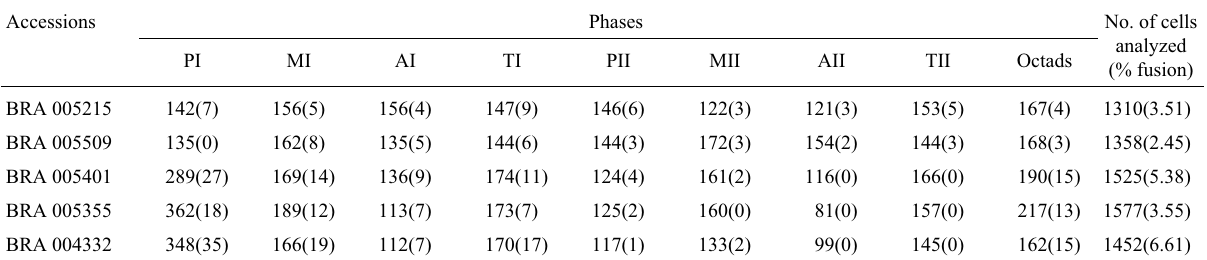
Table 1 - Number of analyzed cells and number of cell fusions per phase during microsporogenesis in five tetraploid accessions of B. jubata .